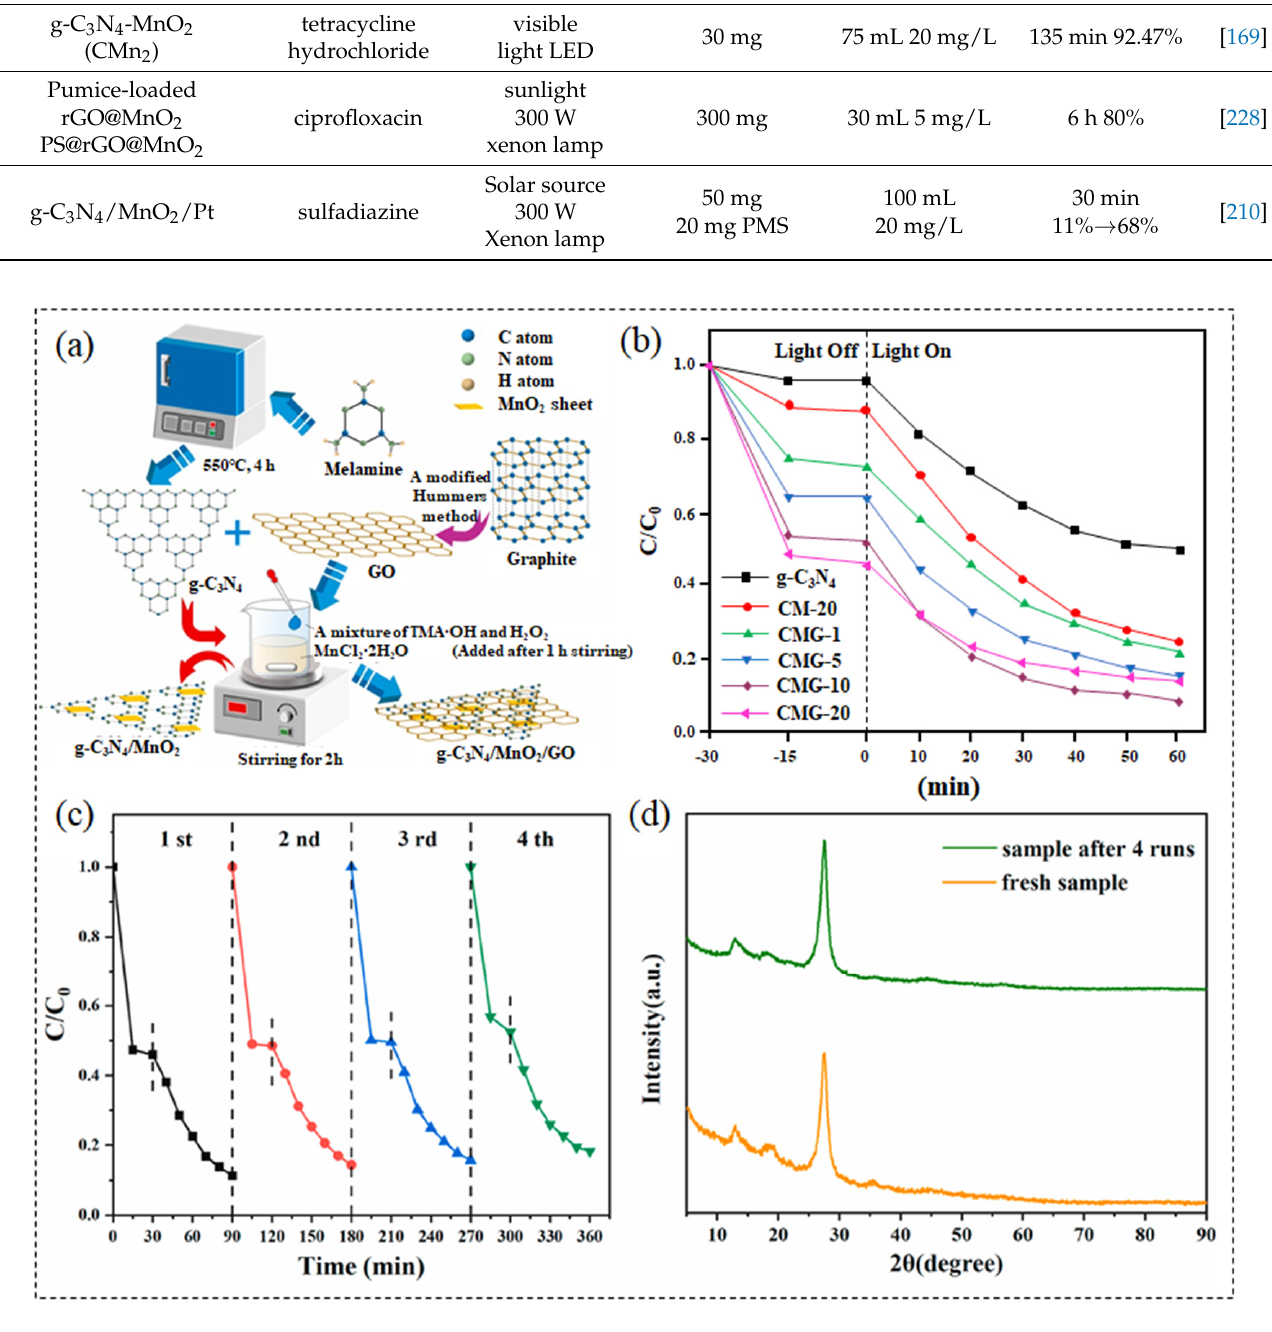
Figure 3. ( a ) Preparation process scheme; ( b ) Photocatalytic degradation rate under the visible light irradiation; ( c ) Recycle experiments for the degradation of TC and ( d ) XRD patterns before and after four runs of CMG-10. Figures reprinted with permission from ref. [227]. Copyright 2021; Elsevier Ltd. Table 3. Study on MnO 2 − carbon materials for photocatalytic degradation of antibiotic in aqueous solution.